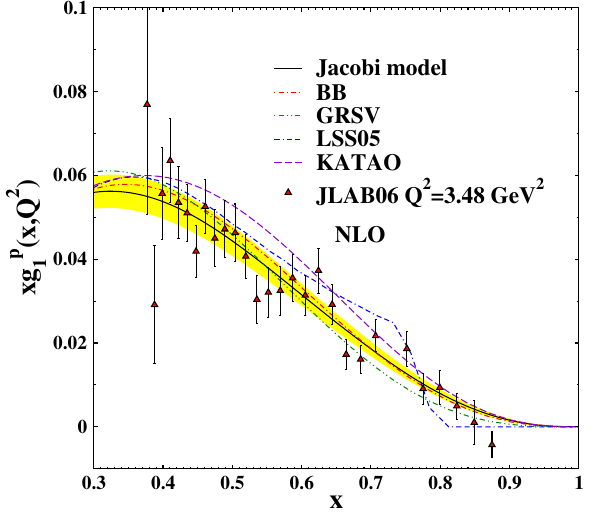
Fig. 3 As in Fig.2 but at Q 2 = 3 . 5 GeV 2 and in a shorter range of x which is corresponding to the available data